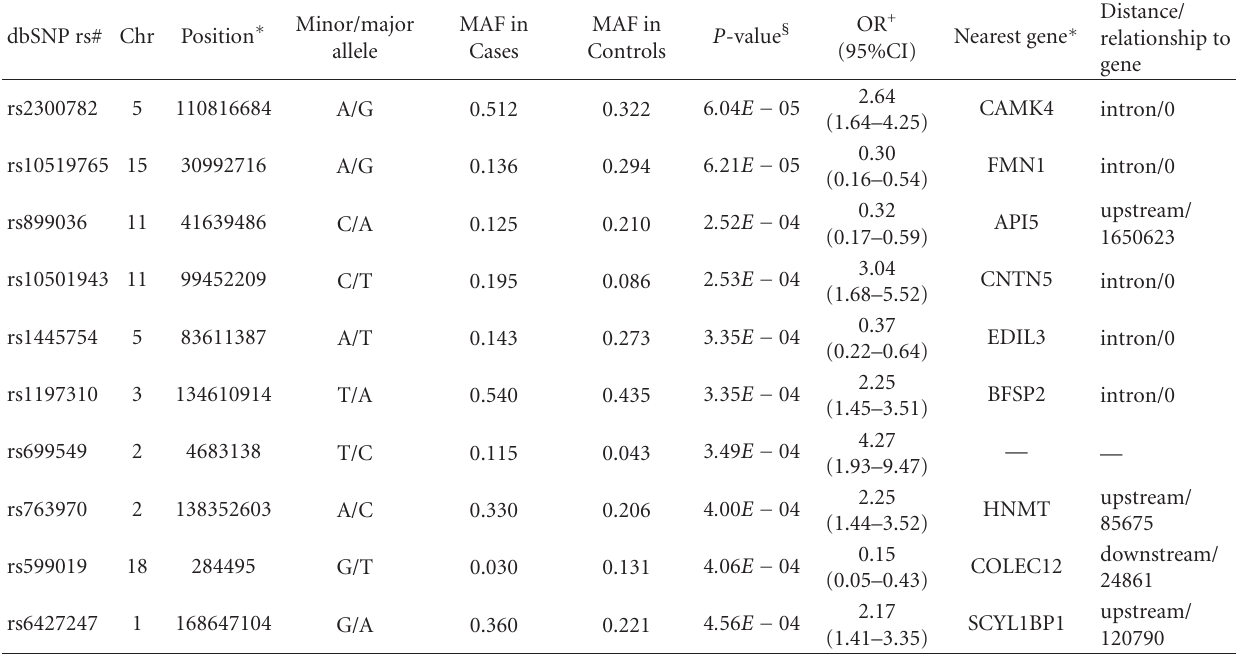
Table 2: Top 10 single-marker associations with severe diabetic retinopathy among Mexican-Americans from Starr County, Texas. dbSNP rs# Chr